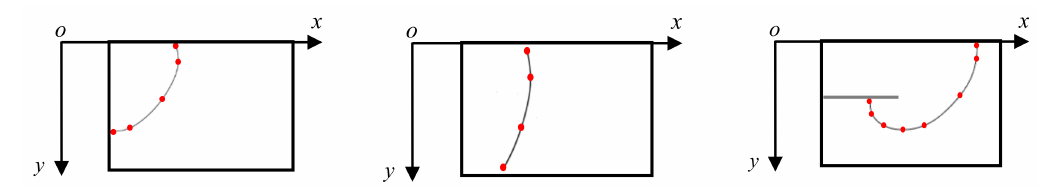
Figure 14. The feature points of the trace lines.